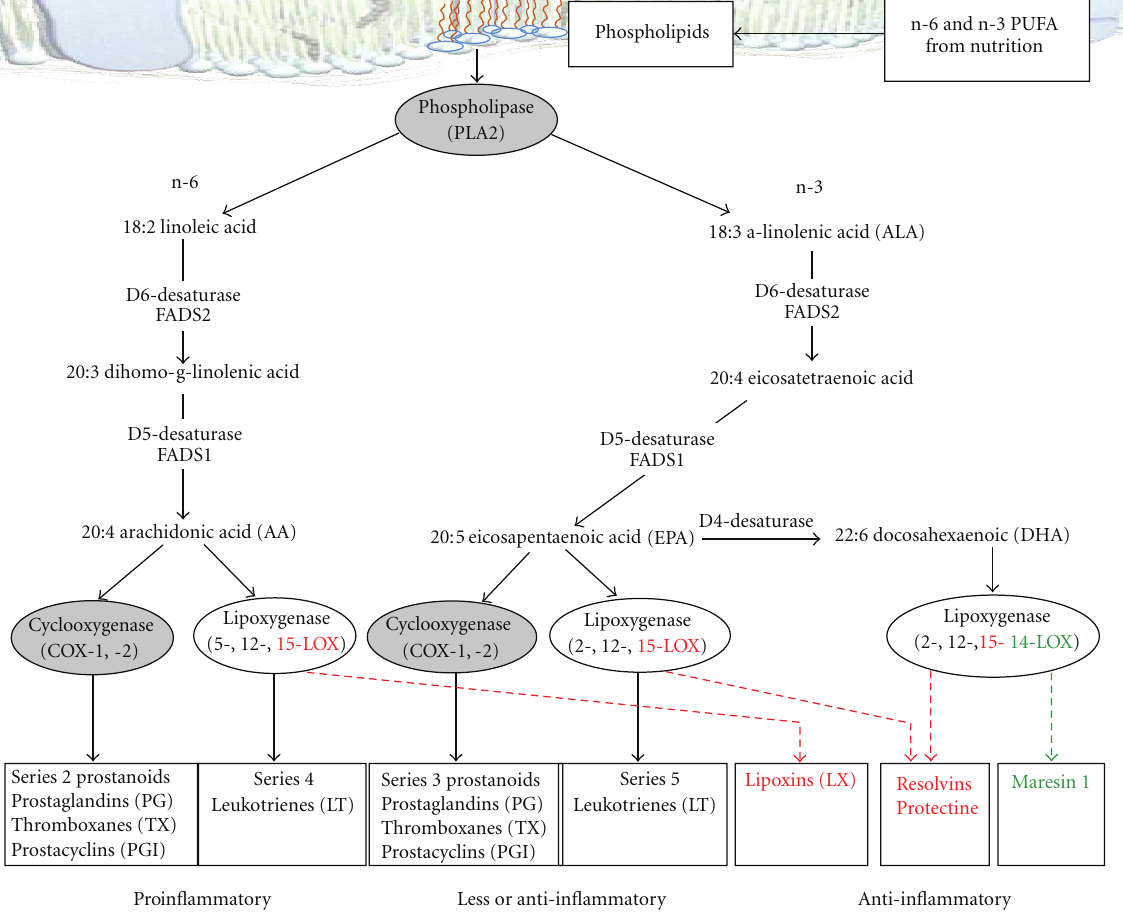
suggests interindividual variations for requirements in n-3